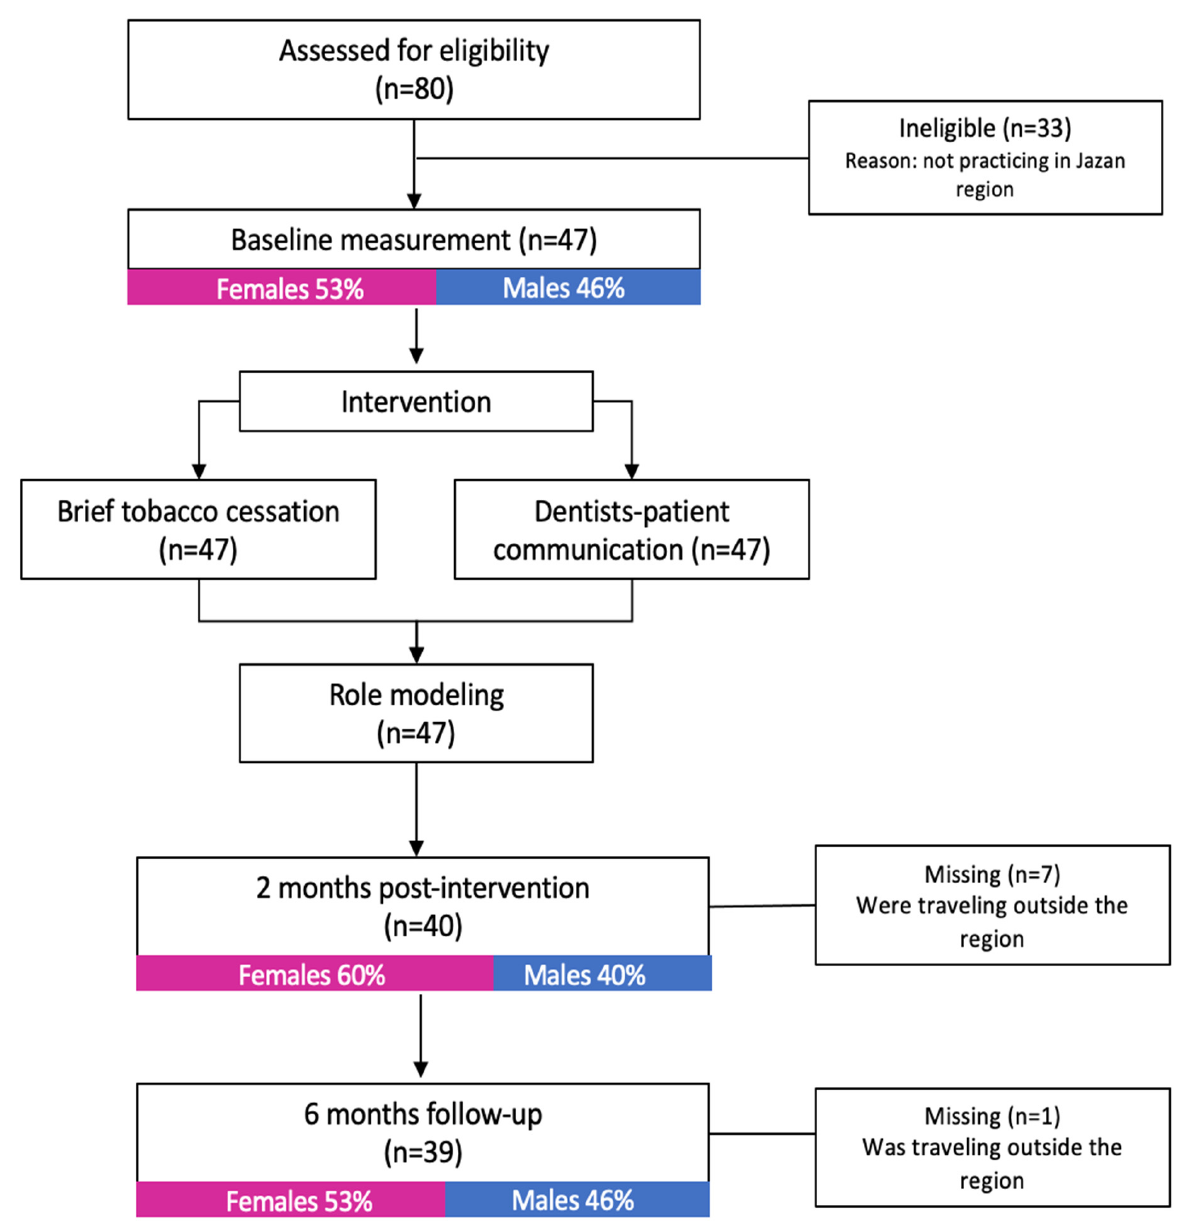
Figure 1. Flowchart of the process evaluation procedure.